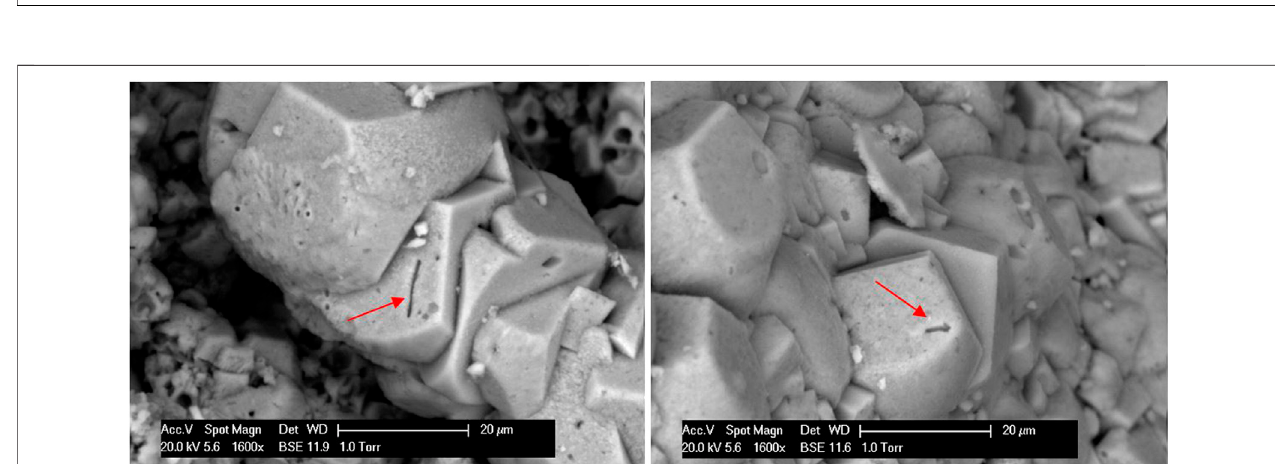
FIGURE 10 | Calcite crystals observed through ESEM analysis of the freshly-split cylinders after 56 days of healing with surface bacterial imprints (indicated by arrows).